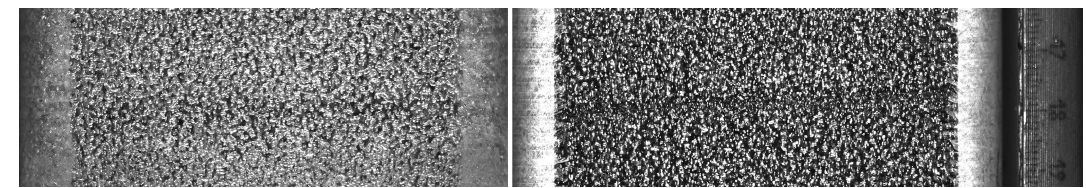
Figure A2. Uncertain melt layers from 102 and 187m depth. Scale on right.